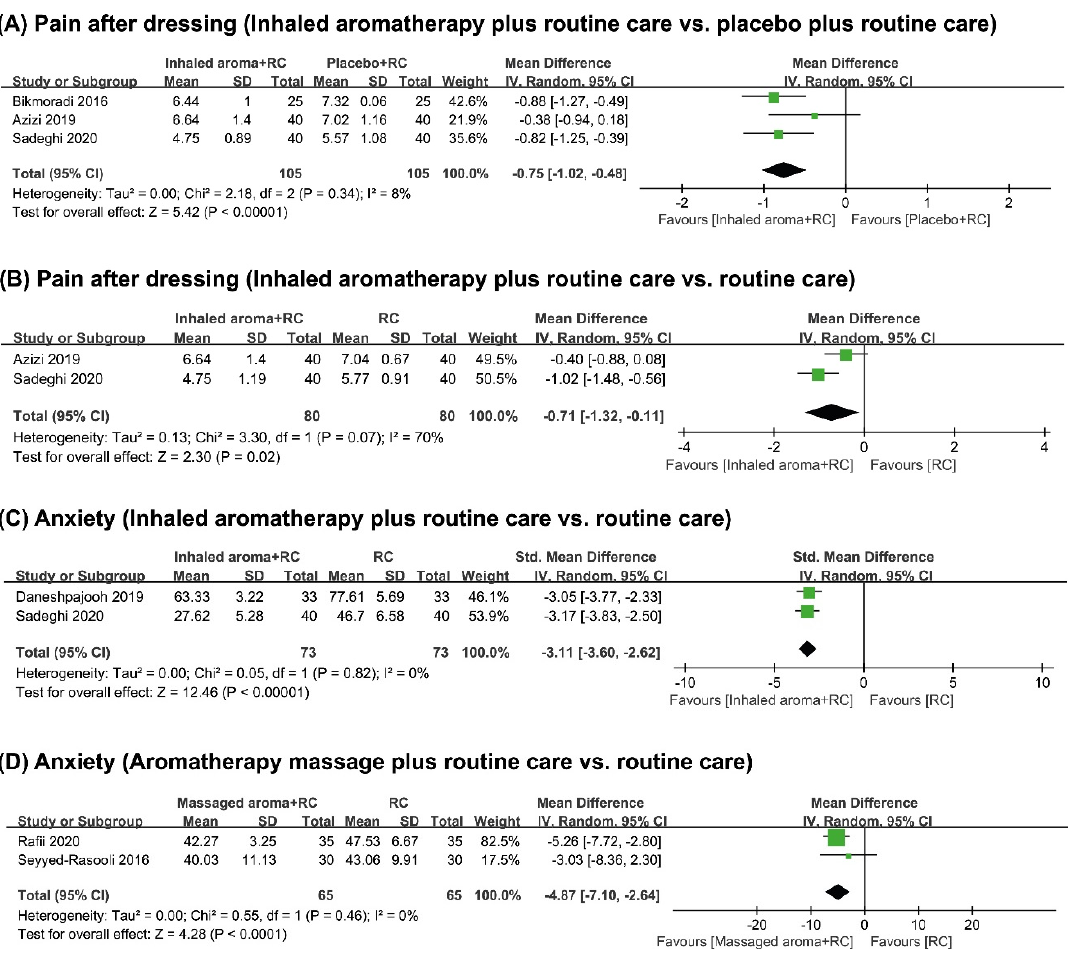
Figure 3. Forrest plot of ( A ) pain outcome after dressing in inhaled aromatherapy plus routine care vs. placebo plus routine care, ( B ) pain outcome after dressing in inhaled aromatherapy plus routine care vs. routine care alone, ( C ) anxiety in inhaled aromatherapy plus routine care vs. routine care alone (after dressing), ( D ) anxiety in aromatherapy massage plus routine care vs. routine care alone.